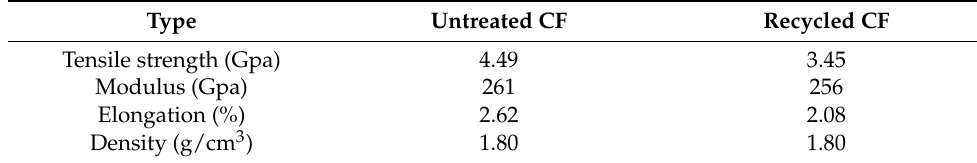
Table 1. Properties of carbon fiber in this